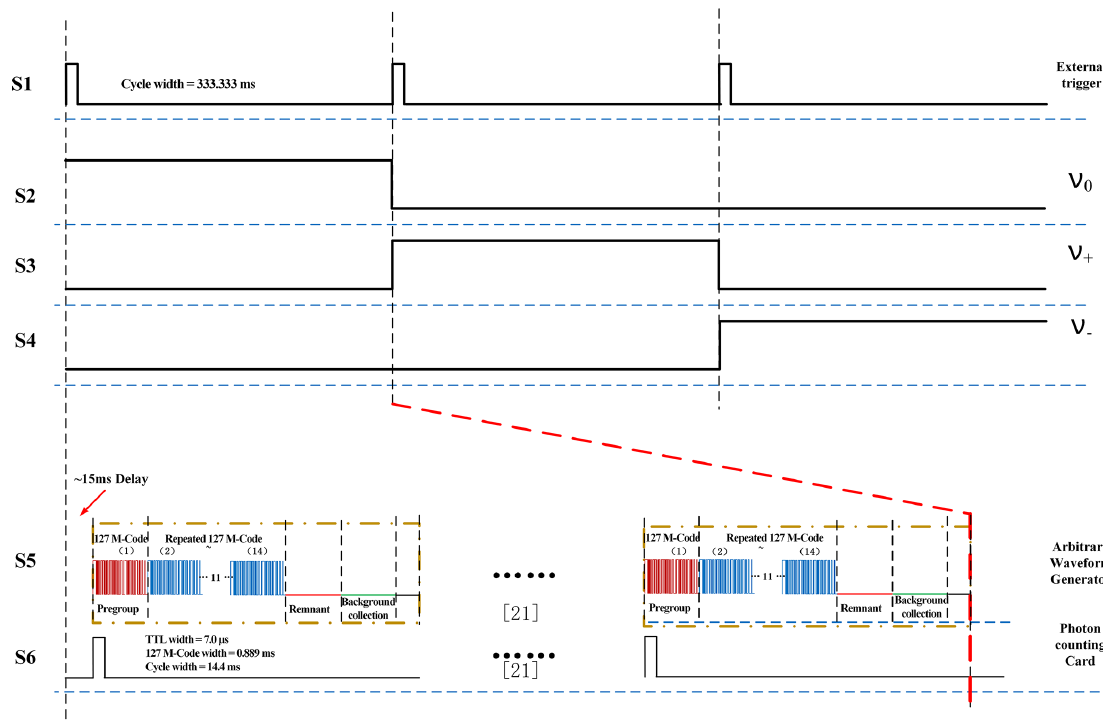
Figure 3. Timing diagram of PMCW-NSL.